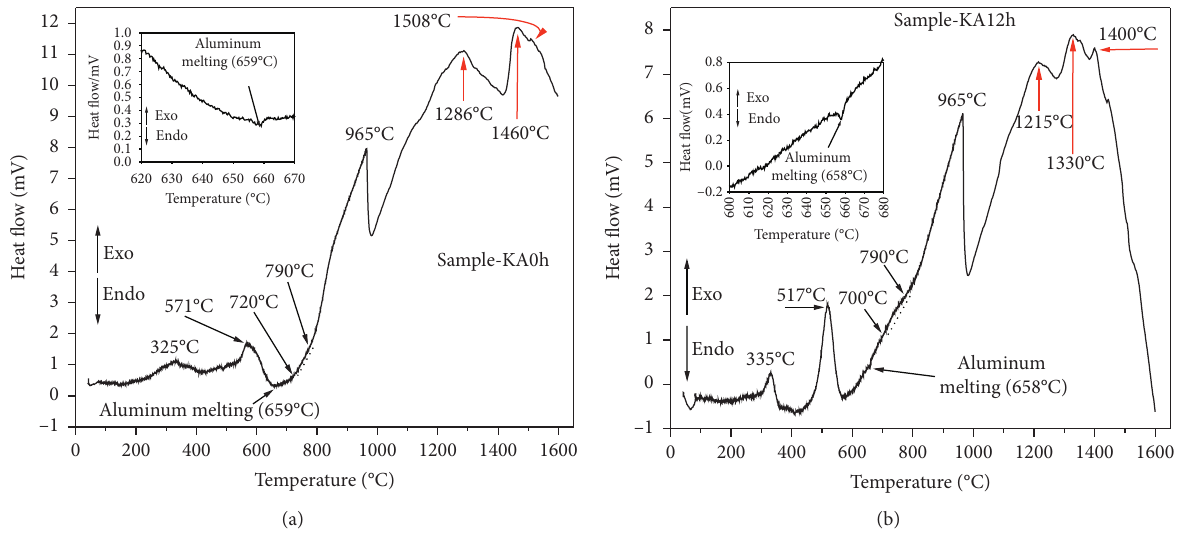
Figure 9: DTA curves of the kyanite-aluminum mixtures unmilled (a) and 12h milled